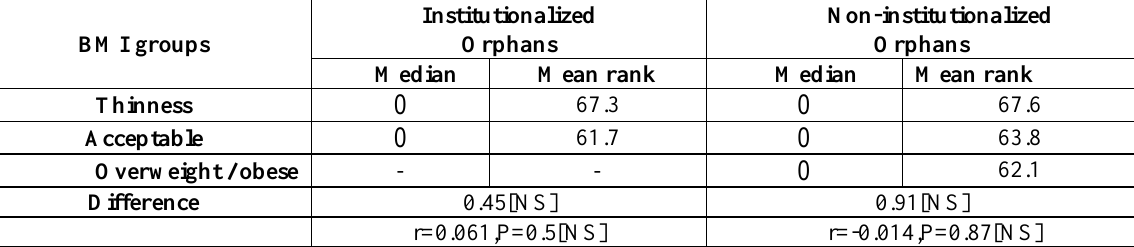
Table 6: Difference in CALI (median and mean rank) among BMI groups of institutionalized and non institutionalized